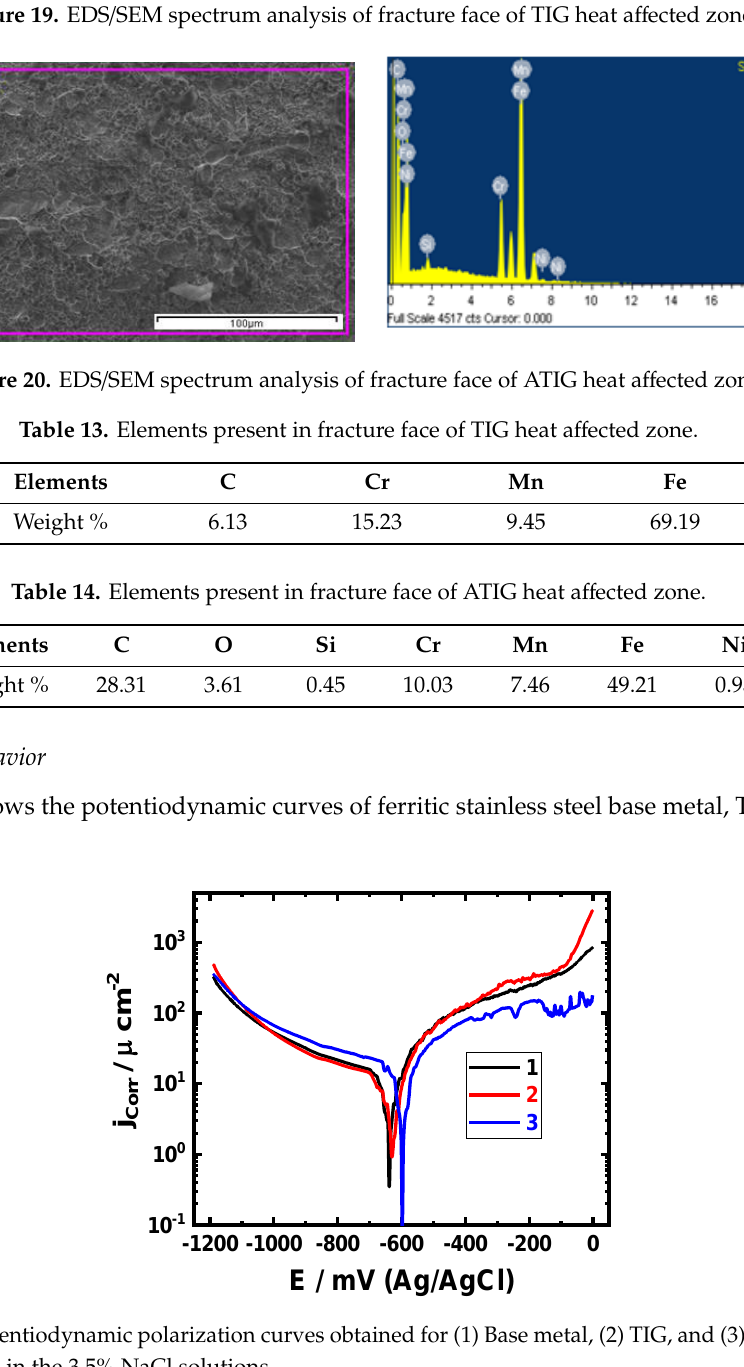
Figure 21. Potentiodynamic polarization curves obtained for (1) Base metal, (2) TIG, and (3) ATIG. after 1 h immersion in the 3.5% NaCl solutions.